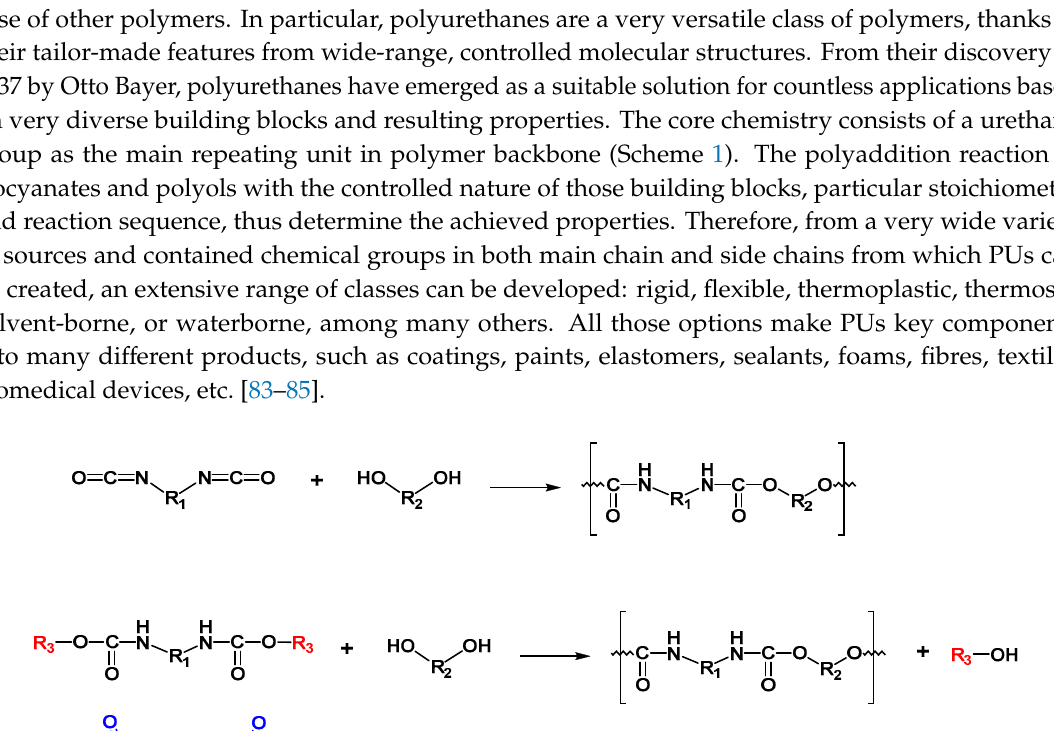
Figure 1. Photo-adjustable patterns with polymers modified with coumarin. Reproduced from [81] with permission from the Royal Society of Chemistry.